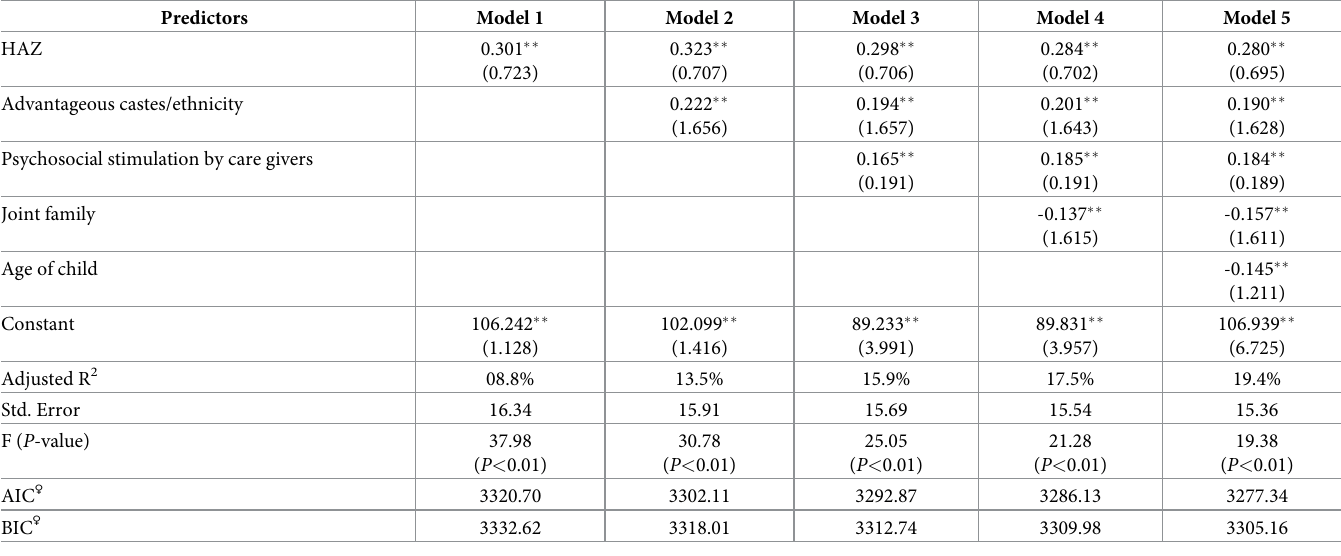
Table 3. Stepwise regression analysis and determinant factors of cognitive